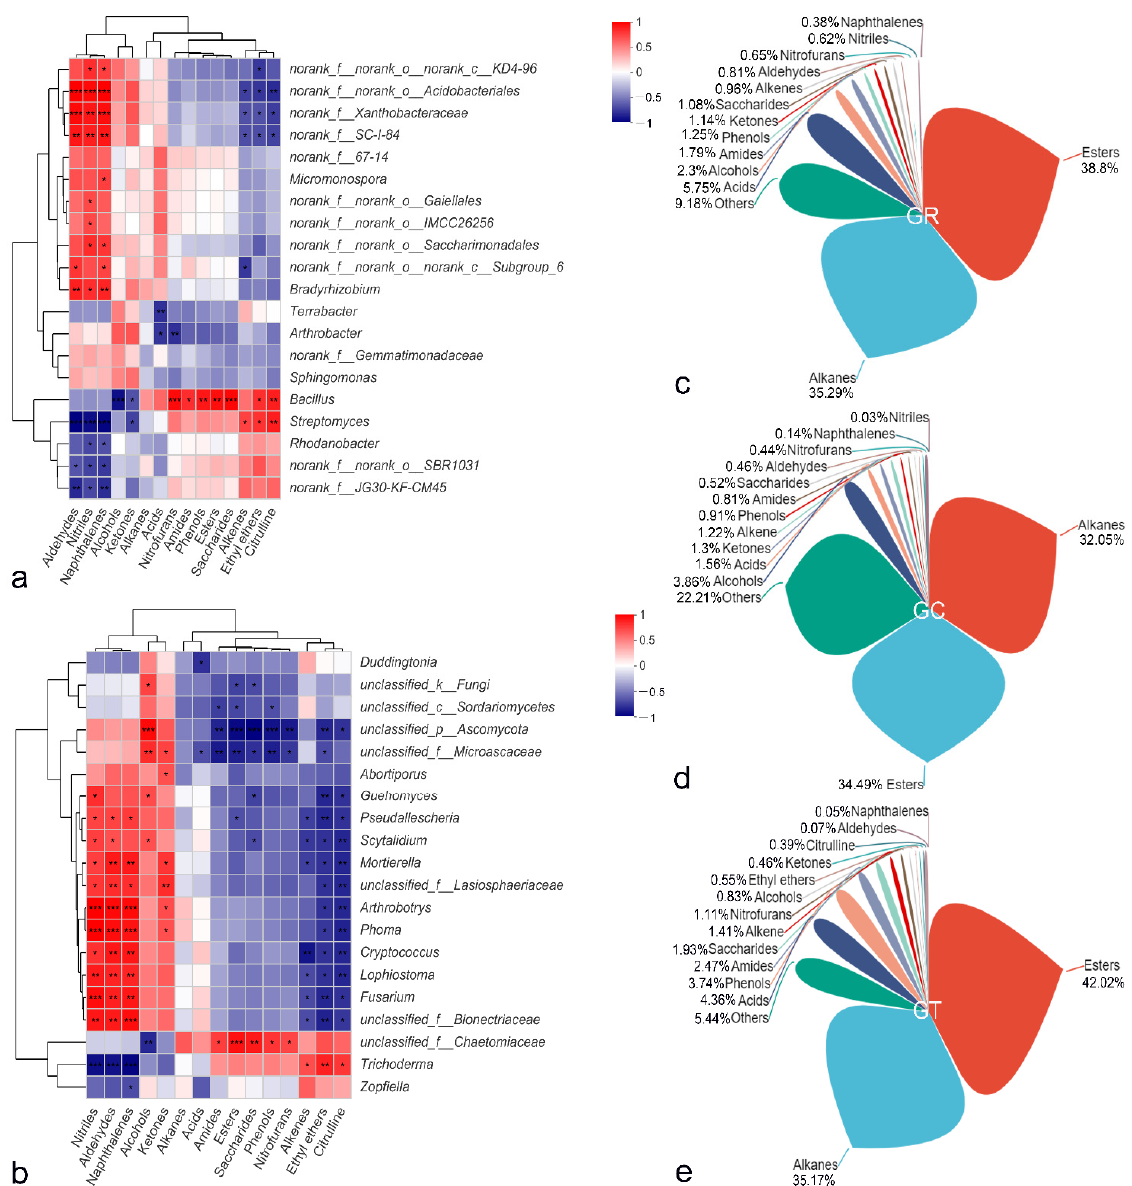
Figure 7. Correlation heatmap of the top twenty bacterial ( a ) and fungal ( b ) genera with root exudates. The x and y axes are root exudates and genera. The legend shows the color range of the R values. Pie charts show the percentages of different root exudate components in GR ( c ), GC ( d ) and GT ( e ). Different colored petals represent different components. GR, control replant soil in the greenhouse experiment; GC, replant soil with blank carrier in the greenhouse experiment; GT, replant soil with 6S-2 fertilizer in the greenhouse experiment. * p ≤ 0.05, ** p ≤ 0.01, *** p ≤ 0.001.